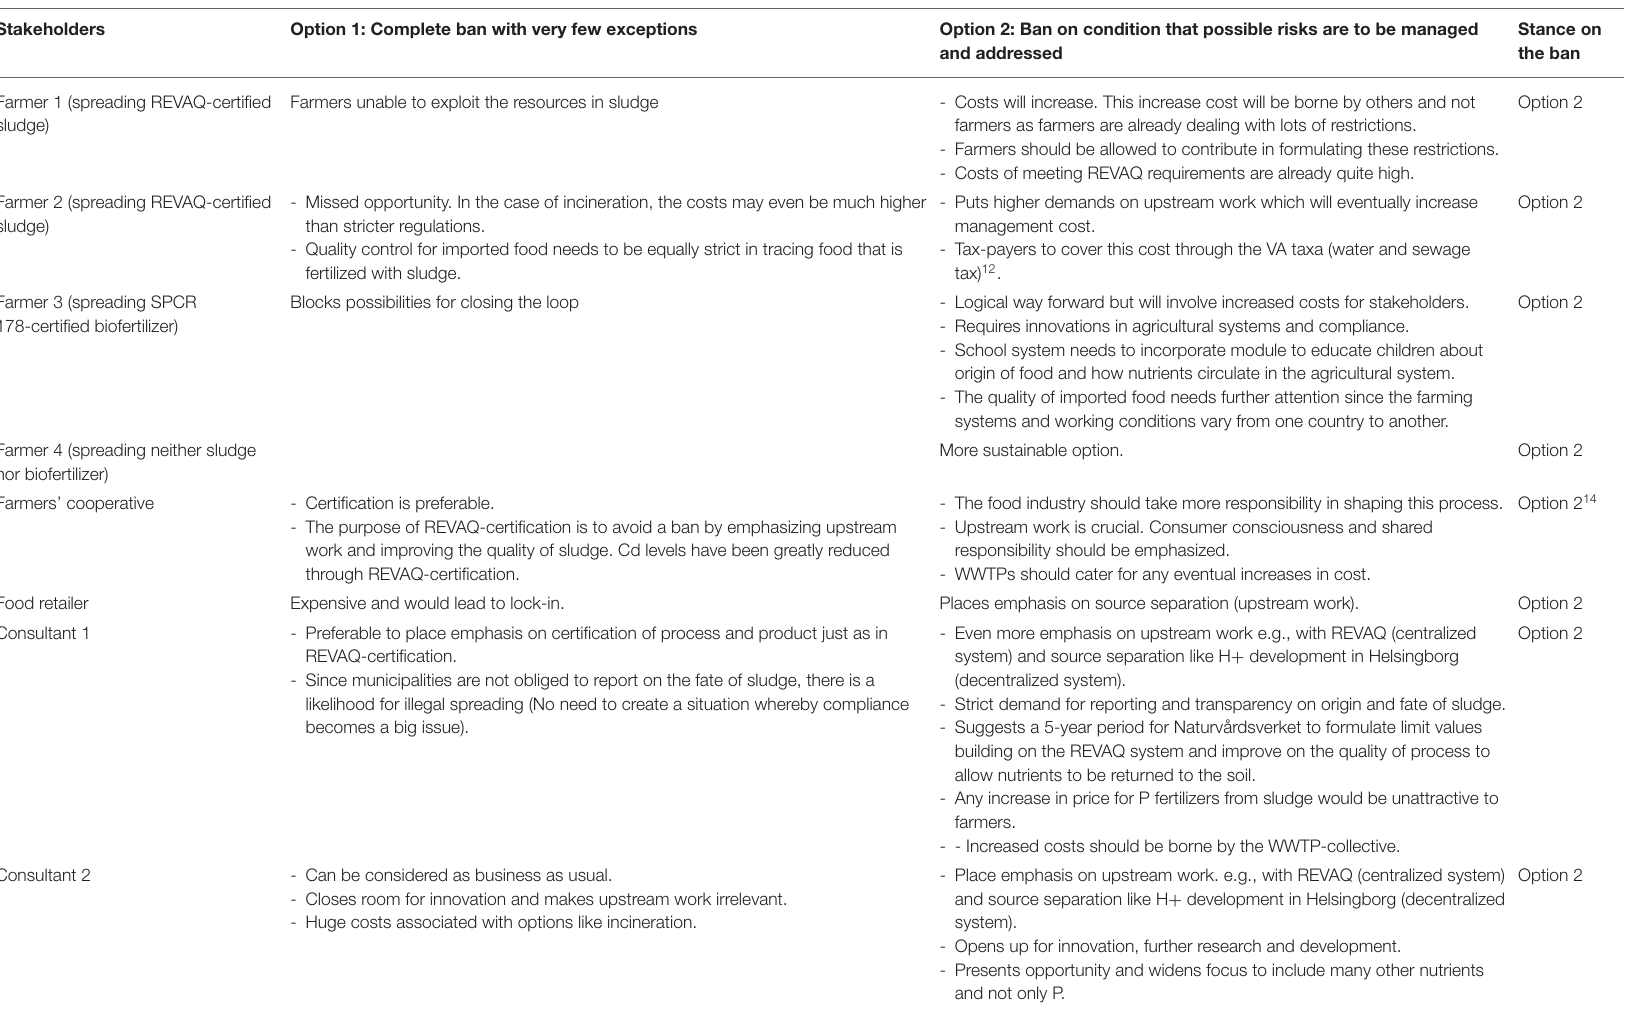
TABLE 6 | Perceptions on the options presented in the recent inquiry (SOU, 2020:3) 13 .